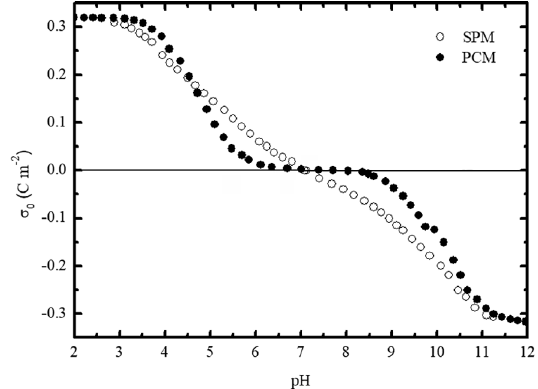
Figure 4. Typical pH-dependence of the surface charge density determined with both methods (sample A). the additional collection of conductivity data has no influence on the total time of analysis because it is simultaneously measured with pH and requires no additional time for reading in the